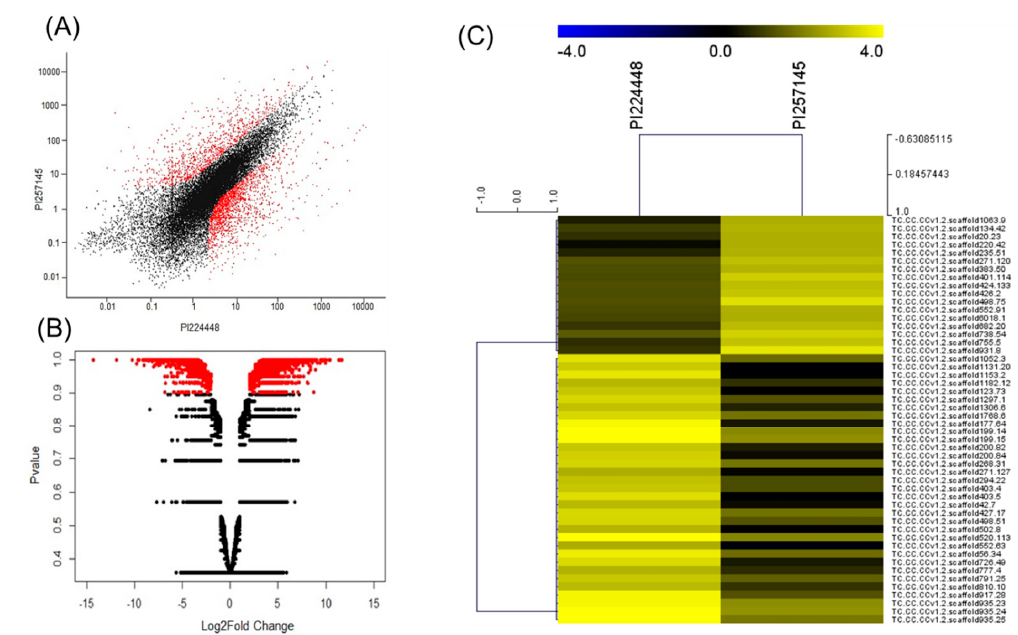
Figure 1. ( A ) Summary plot of expression values for the genotypes PI 257145 and PI 224448. The red points represent the genes with significant p -value of ≥ 0.9. ( B ) Volcano plot showing the Log2 fold change (FC) of differentially expressed genes (DEGs) in PI 257145 versus PI 224448. The Log2FC is plotted on the x -axis and the p -value is plotted on the y-axis. The red points in the scatter-plot show the DEGs with p -value ≥ 0.9 and the black points are less significant with p -value > 0.9. ( C ) Top 50 differentially expressed genes between the genotypes PI 224448 and PI 257145 based on the fragments per kilobase of transcripts per million (FPKM) normalized Log10-transformed counts. The color key yellow represents high expression and blue represents low expression.